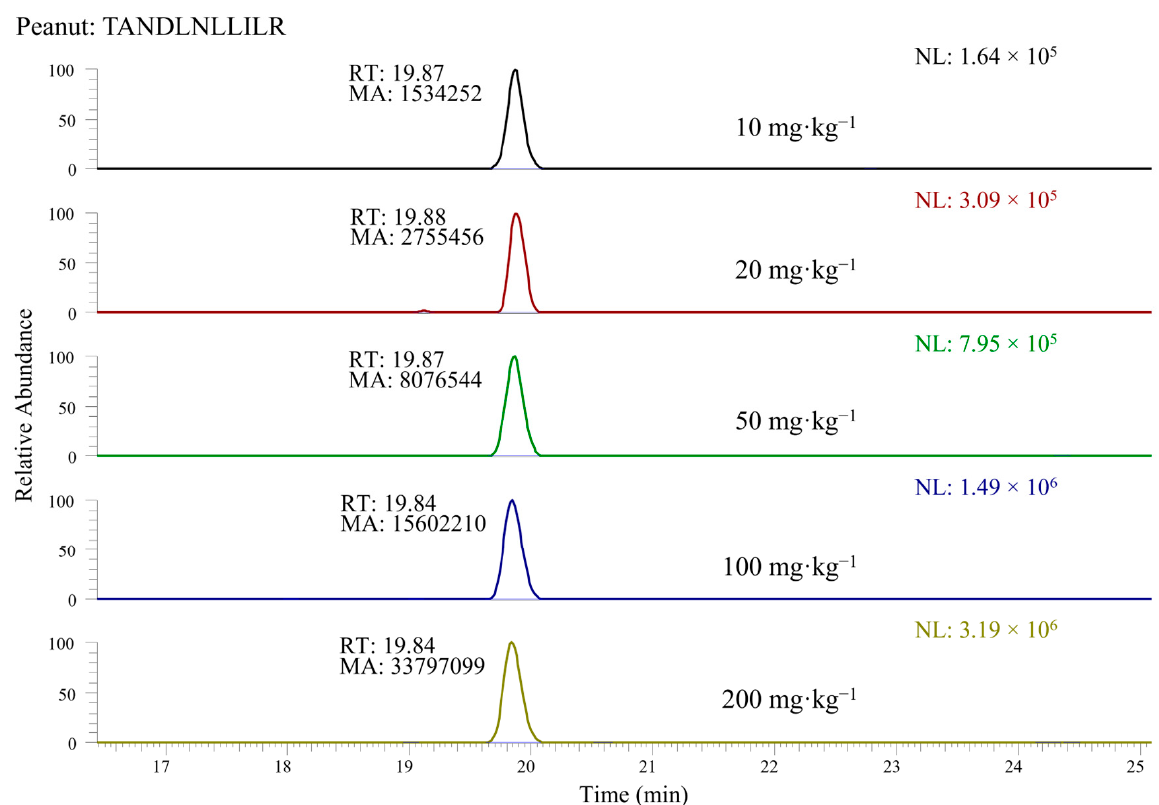
Figure 2. Example of XIC chromatograms related to the doubly charged peptide TANDLNLLILR (belonging to the peanut protein Ara 3) detected in the tryptic digests of protein extracts of cookies with concentrations of allergenic ingredients ranging from 10 to 200 mg·kg − 1 .